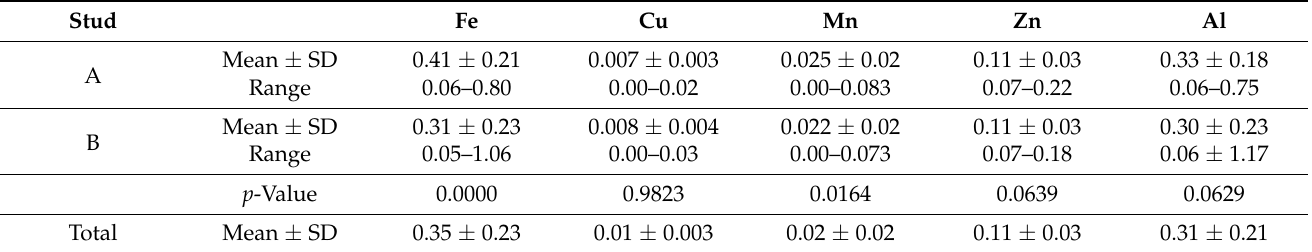
Table 2. Levels of selected micronutrients in coats of Hucul horses (mg · g − 1 ).